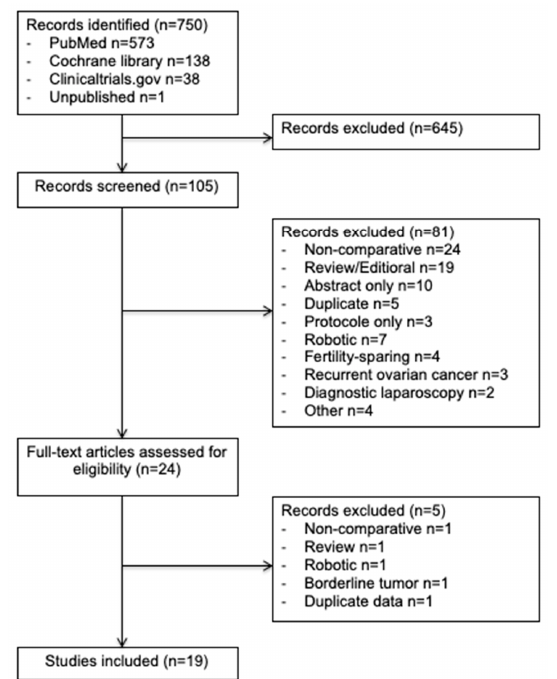
Figure 1. Preferred Reporting Items for Systematic Reviews and Meta-Analyses (PRISMA) Flow Diagram.